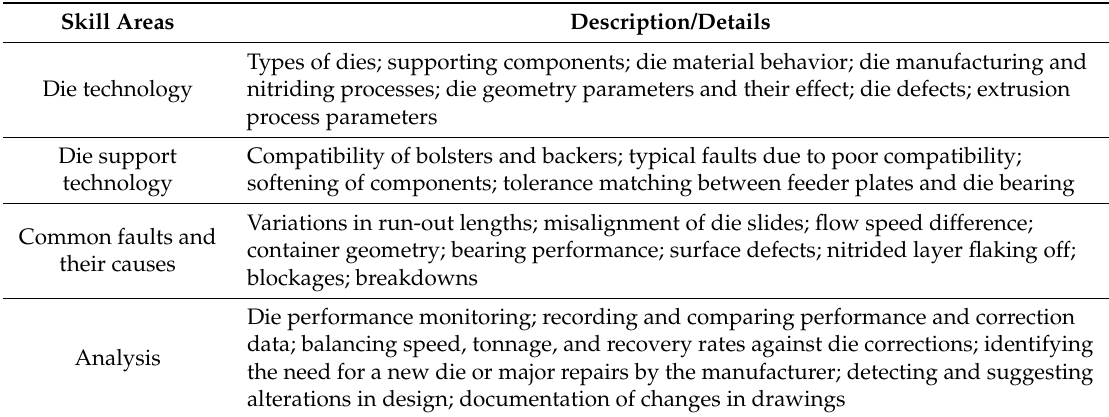
Table 2. Some of the important skills and knowledge required for a die